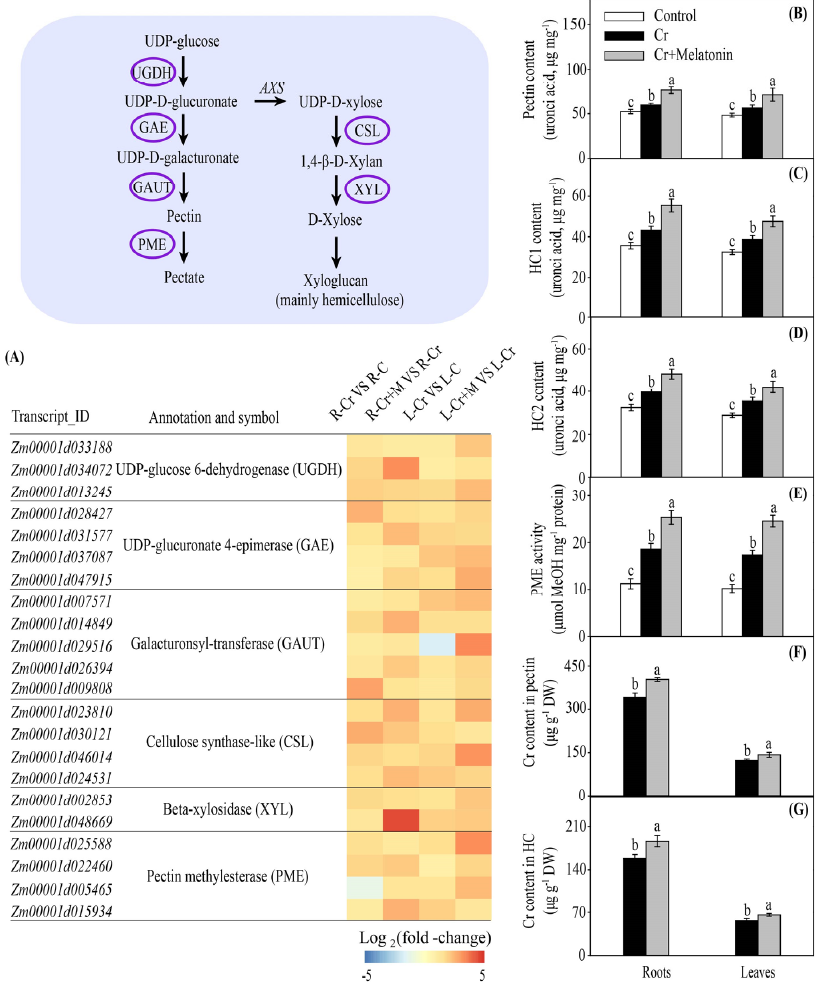
Figure 4. Melatonin and Cr induced changes in gene transcripts involved in cell wall polysaccharide metabolism in maize roots and leaves ( A ). The color scale represents log 2 (fold-change). The effect of melatonin on the uronic acid contents of cell wall polysaccharides (( B ), pectin; ( C ), hemicellulose 1; ( D ), hemicellulose 2), pectin methylesterase (PME) activity ( E ), Cr contents in the cell wall pectin ( F ), and the Cr contents in the cell wall hemicellulose ( G ) in maize roots and leaves under Cr stress. Different letters in one measure (roots or leaves) denote significant differences at p < 0.05. Data are shown as mean ± SE ( n = 3).